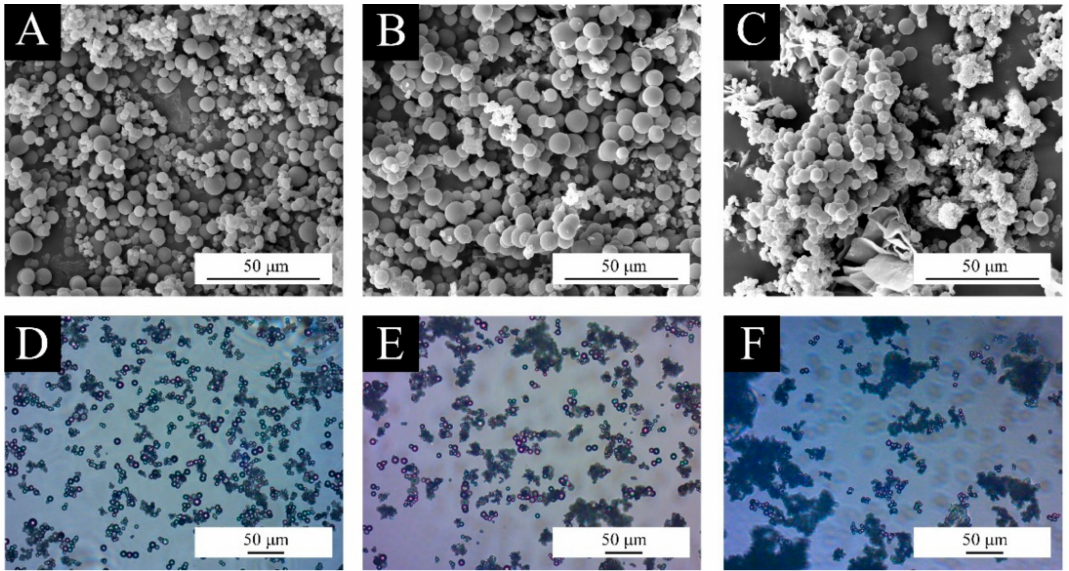
Figure 2. The micromorphology of transparent, purple, and yellow shellac microcapsules: ( A ) SEM image of transparent shellac microcapsules, ( B ) SEM image of purple shellac microcapsules, ( C ) SEM image of yellow shellac microcapsules, ( D ) OM image of transparent shellac microcapsules, ( E ) OM image of purple shellac microcapsules, ( F ) OM image of yellow shellac microcapsules.